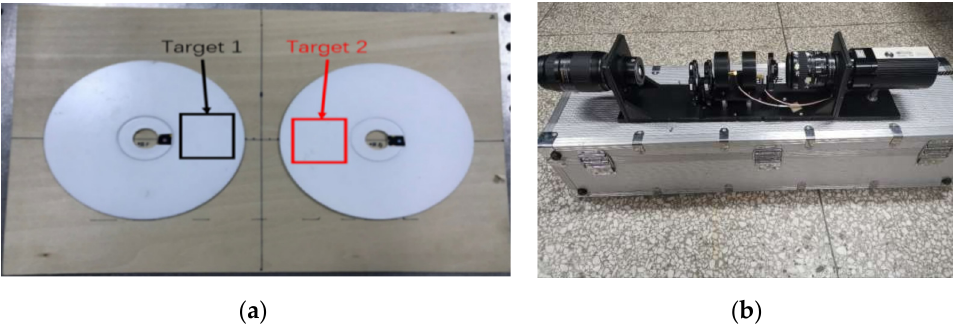
Figure 6. ( a )Indoor experimental target. ( b ) LCVR-based polarized remote sensor. The polarimetric images of targets were captured using our LCVR-based